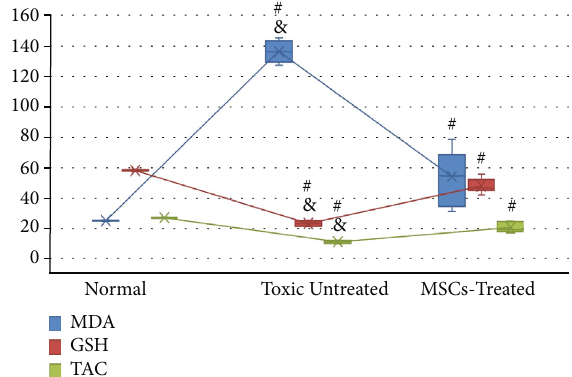
Figure 11: Box blot graph showing means of testicular MDA, GSH, and TAC levels in di ff erent study groups. All data were expressed as means ± SD and were analysed using one-way ANOVA and Bonferroni post hoc test. # indicates a highly signi fi cant di ff erence compared to the normal group ( P < 0 : 001 ). & indicates a highly signi fi cant di ff erence compared to the MSC-treated group ( P < 0 : 001